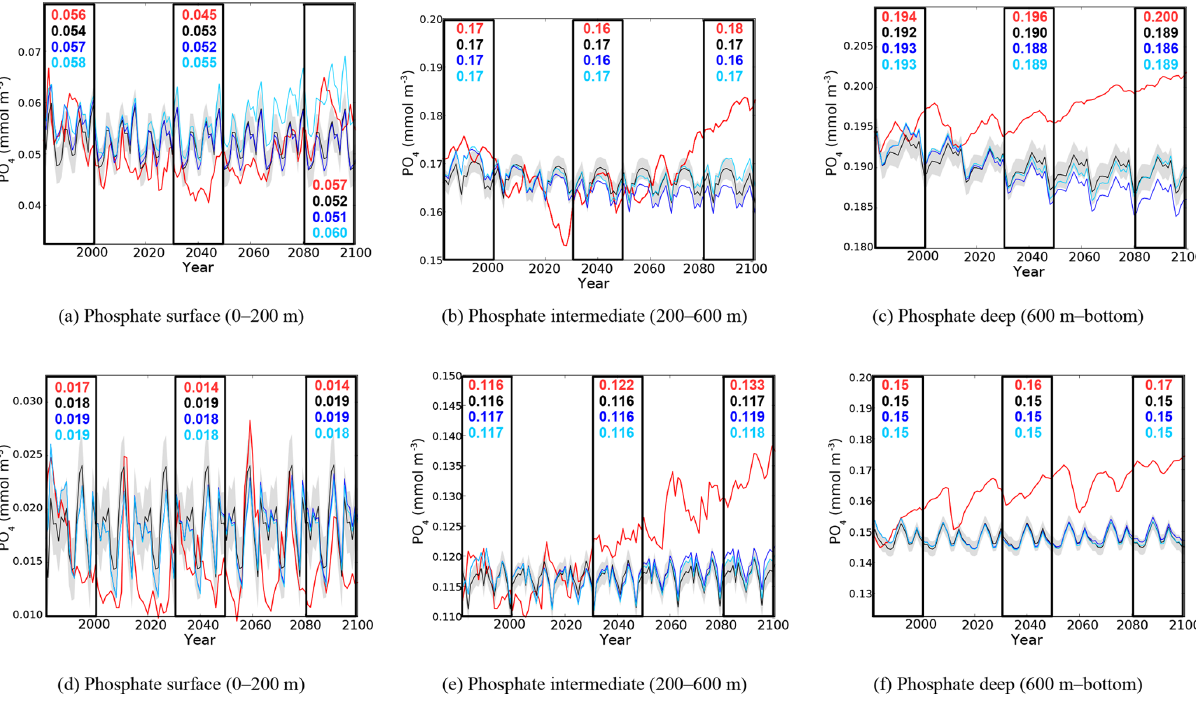
Figure 7. Evolution of yearly average phosphate concentration (10 − 3 molm − 3 ) in the surface (a, d) , intermediate (b, e) , and bottom (c, f) layers in the western (a, b, c) and eastern (d, e, f) basin. Red lines represent the HIS/A2 simulation, black lines represent the CTRL (with standard deviation), and blue and light blue lines represent the CTRL_R and CTRL_RG simulations respectively. Colored numbers in the highlighted areas represent the average concentrations in the corresponding simulations for the highlighted time